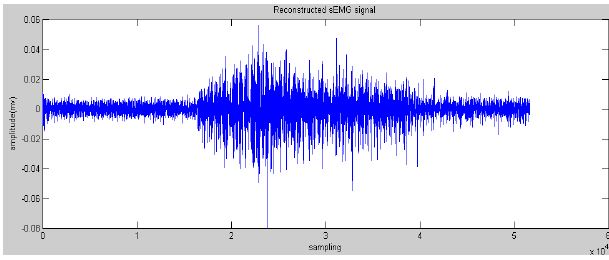
Figure 5. Reconstructed sEMG signals processed by Wavelet Packet Transform (WPT) in node 4.0.